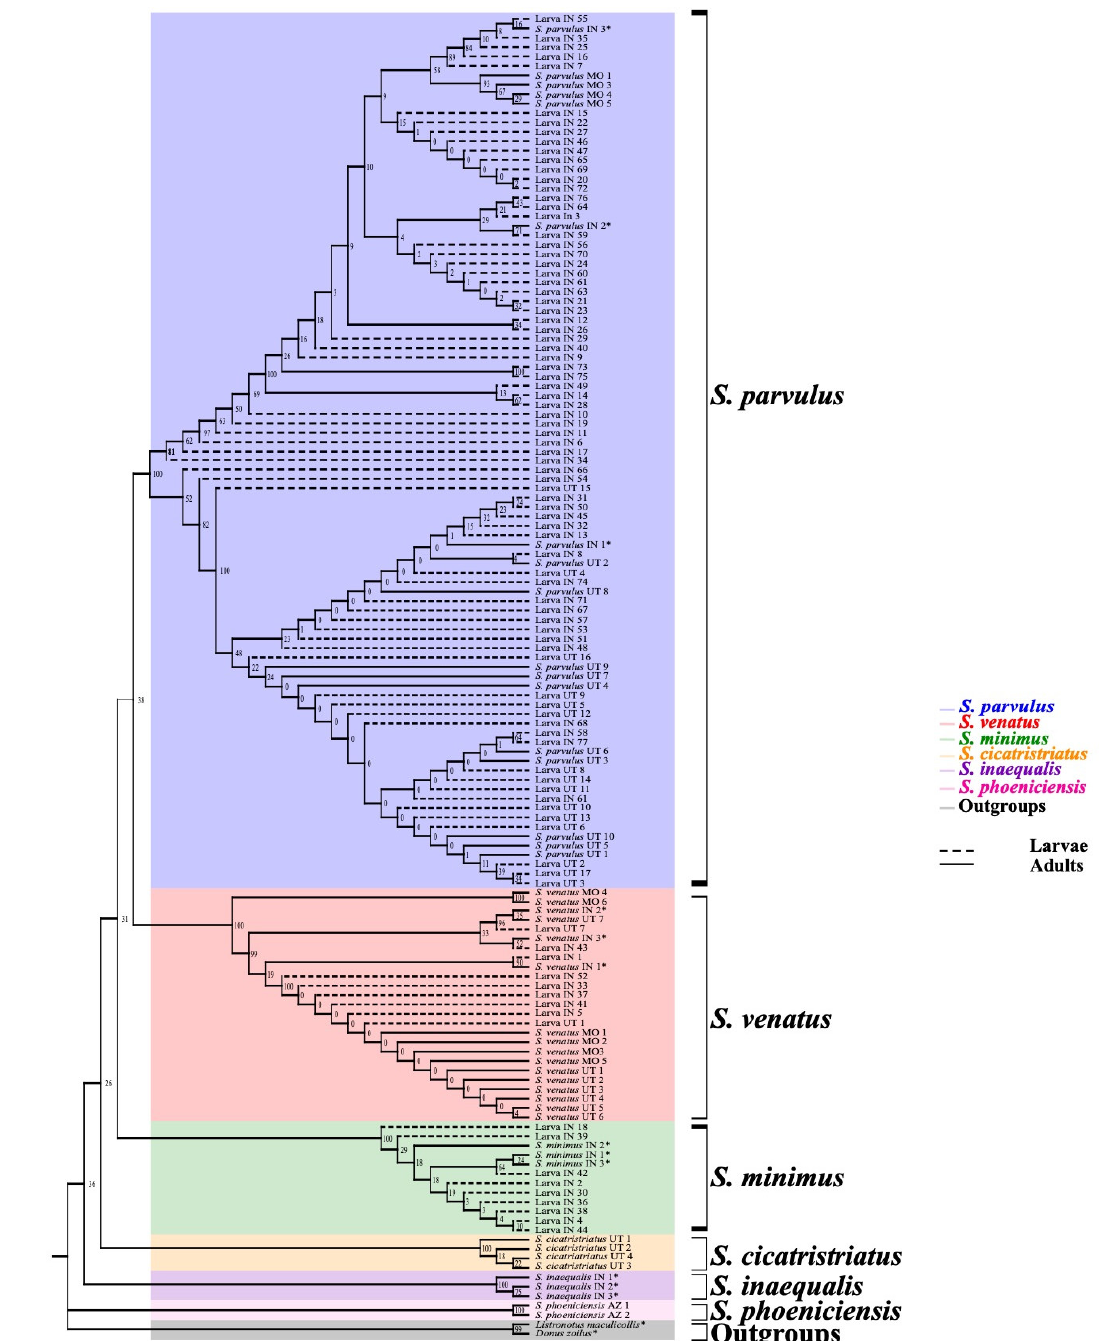
Figure 5. Maximum likelihood tree of COI sequences from adults and larvae. Larvae are represented as dashed lines and were identified based on their position in the tree with bootstraps values ≥50%. Larvae were successfully grouped with adult species included in the reference database, species groupings are represented by color blocks: Sphenophorus parvulus (blue), S. venatus (red), S. minimus (green), S. inaequalis (purple), S. cicatristriatus (orange), and S. phoeniciencis (pink). Replicate numbers are indicated to the right of the scientific name and collection state (Utah = UT, Indiana = IN, Missouri = MO, Arizona-AZ). Numbers at nodes are bootstraps values (1000 bootstrap replicates as percentages). * indicates sequences obtained from [17].